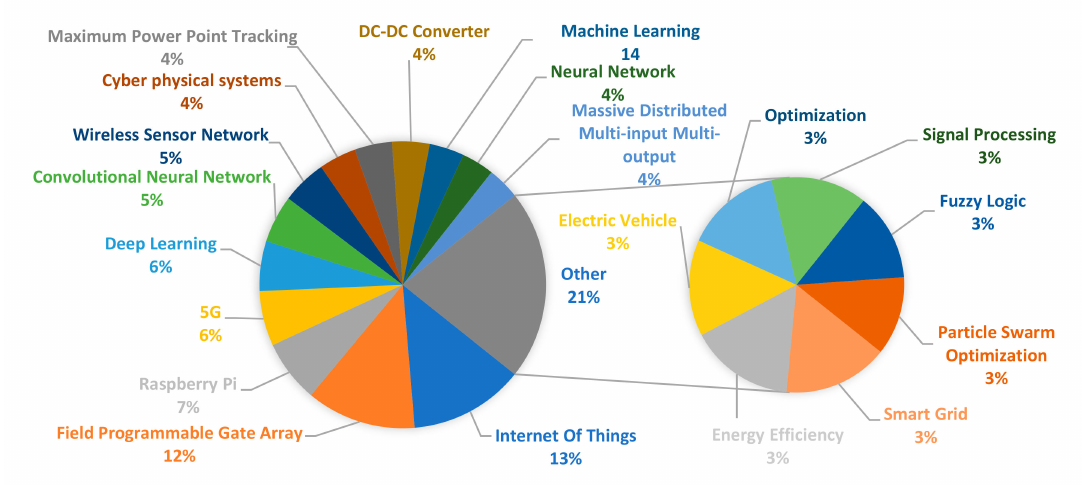
Figure 10. Representation of the 20 most repeated global keywords.